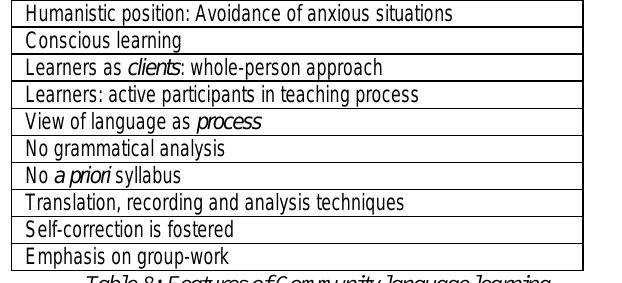
Table 8: Features of Community language